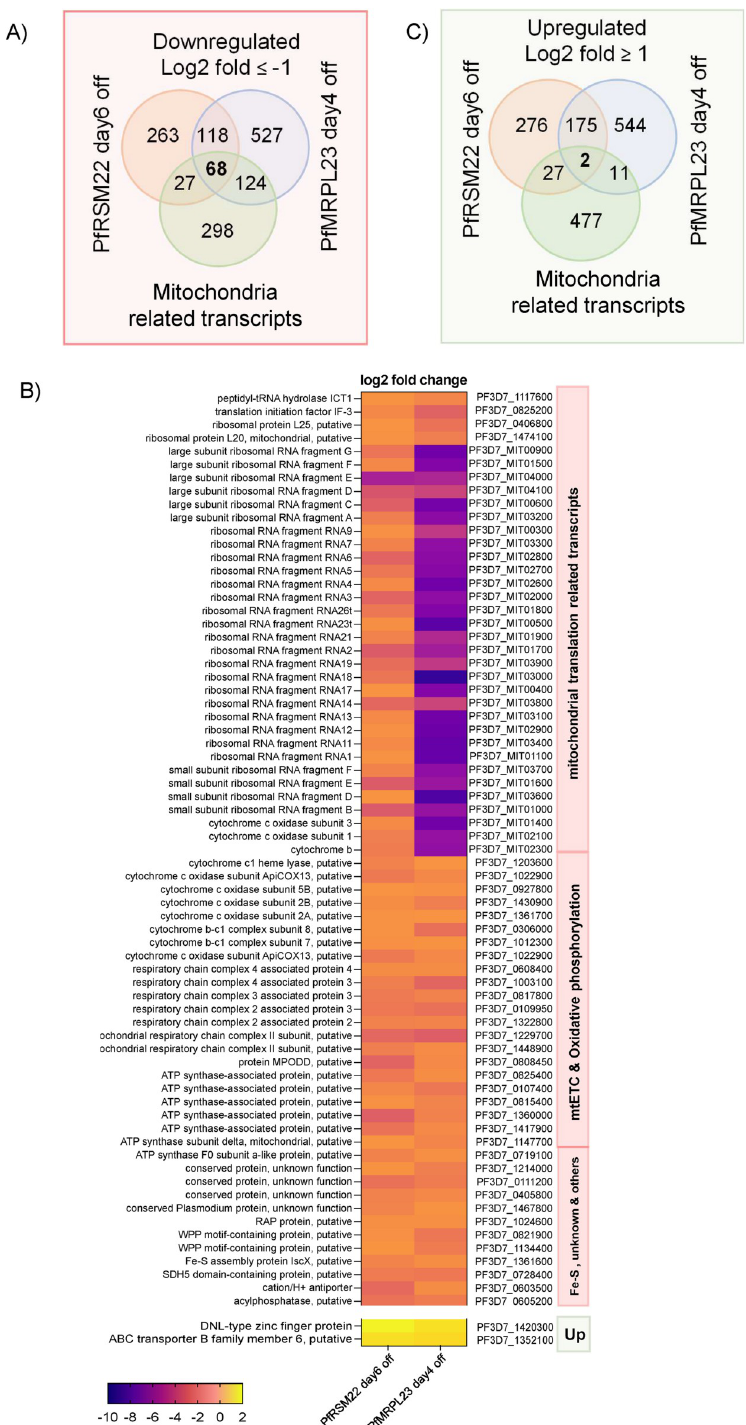
Fig 7. Genes regulated in common after KD of PfRSM22 and PfMRPL23 in the late phase. (A) Venn diagrams depict the relationship of downregulated gene transcripts in the PfRSM22 KD line on day 6 (orange) and in the PfMRPL23 KD line on day 4 (blue) to the 517 mitochondrial related transcripts (green). Transcripts downregulated � 2-fold are included in this analysis. (B) Heat map of commonly downregulated (68 genes) and upregulated genes (2 genes) between PfRSM22 KD and PfMRPL23 KD at the late phase. (C) Venn diagrams depict the relationship of upregulated gene transcripts in the PfRSM22 KD line on day 6 (orange) and in the PfMRPL23 KD line